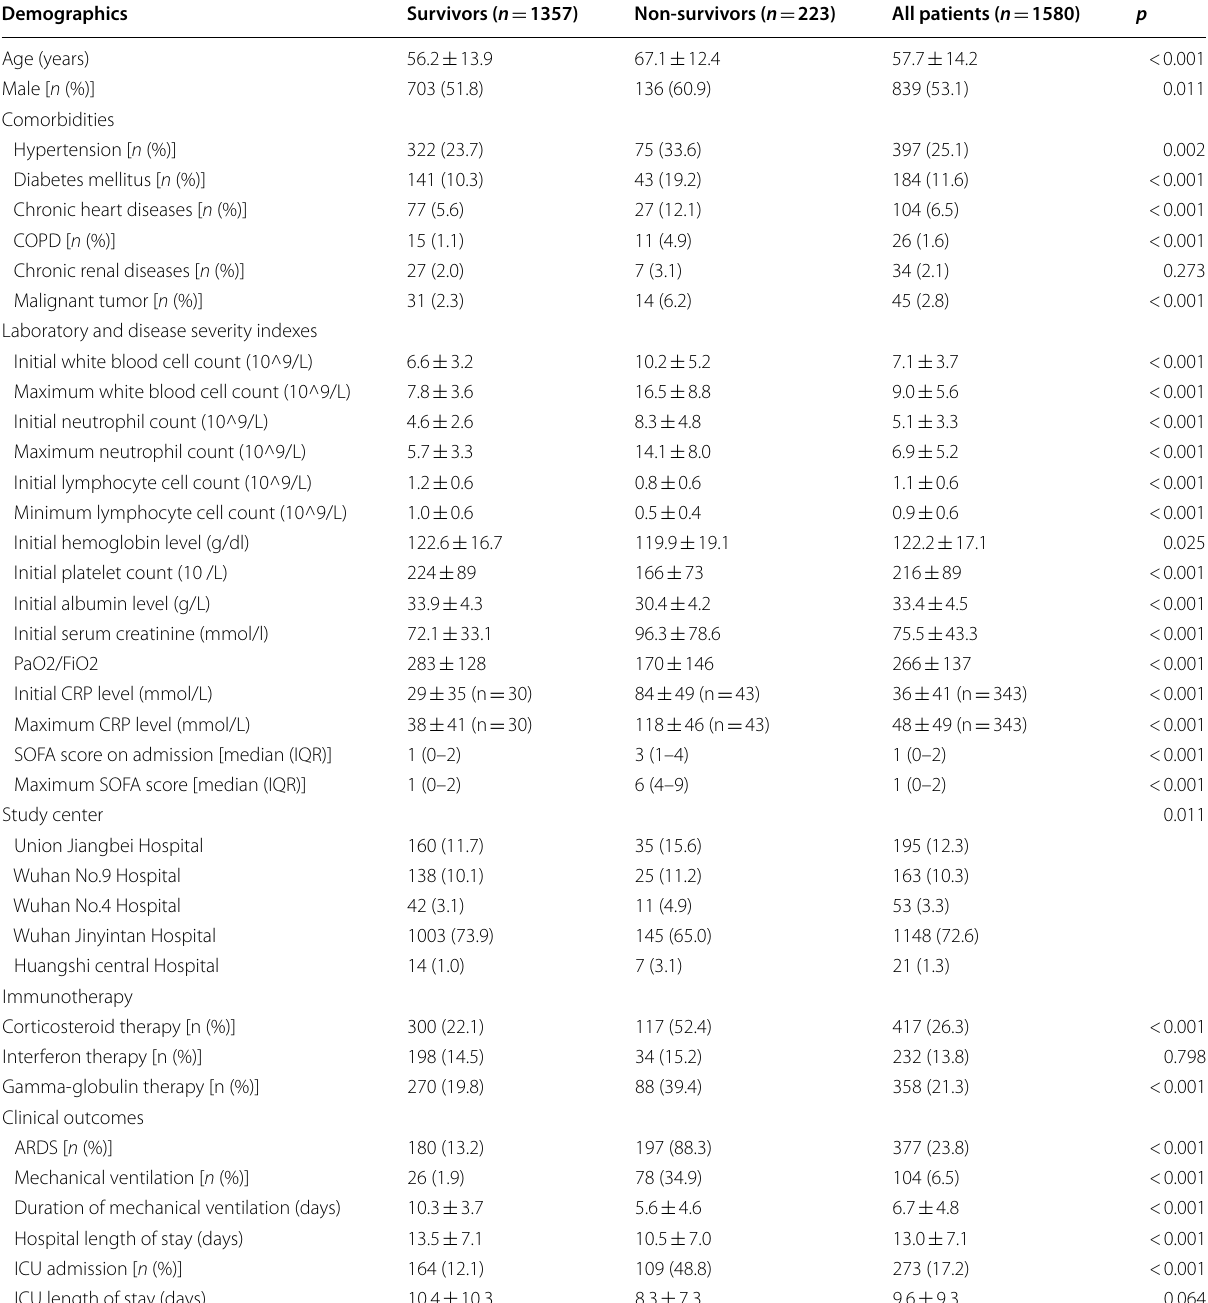
Table 1 Comparison of baseline characteristics between survivors and